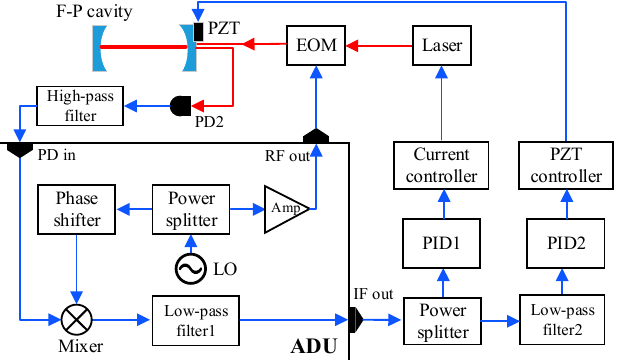
Figure 5. The scheme of the dual-feedback locking loop. LO, Local oscillator; ADU, advanced drive unit; F-P, Fabry–Perot; RF, radio frequency; IF, intermediate frequency.